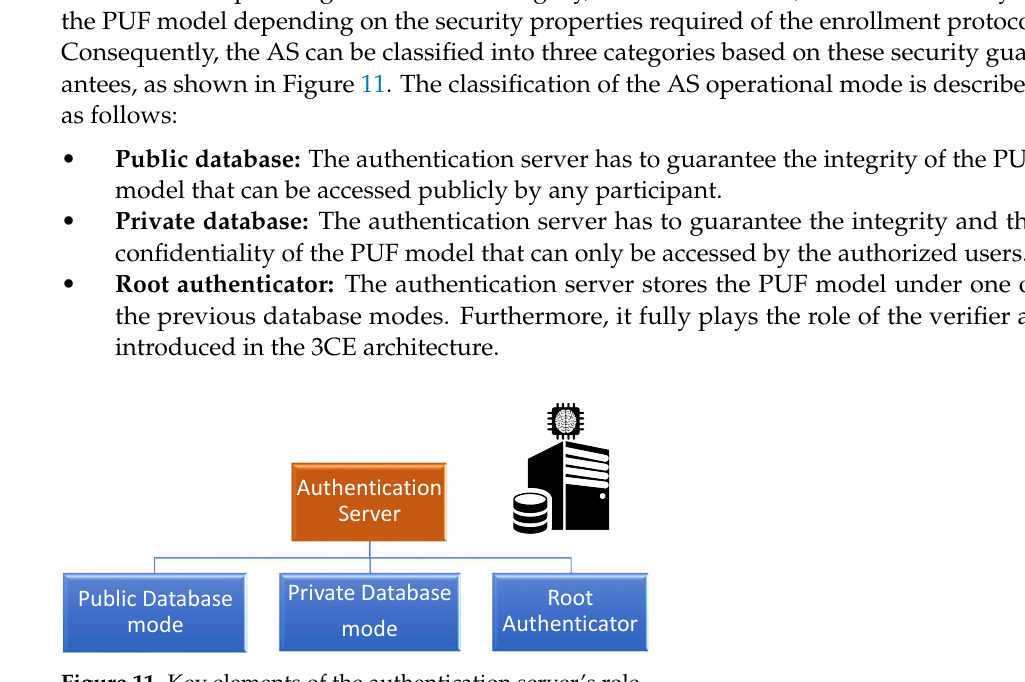
Figure 11. Key elements of the authentication server’s